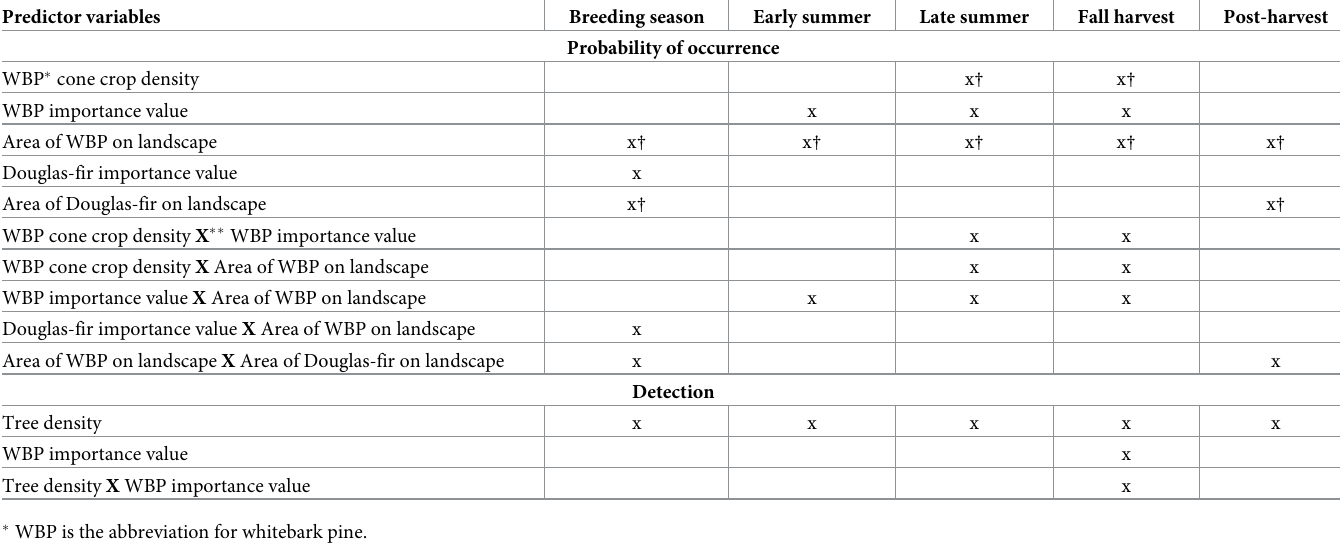
Table 2. Predictor variables originally included in the single-season occupancy